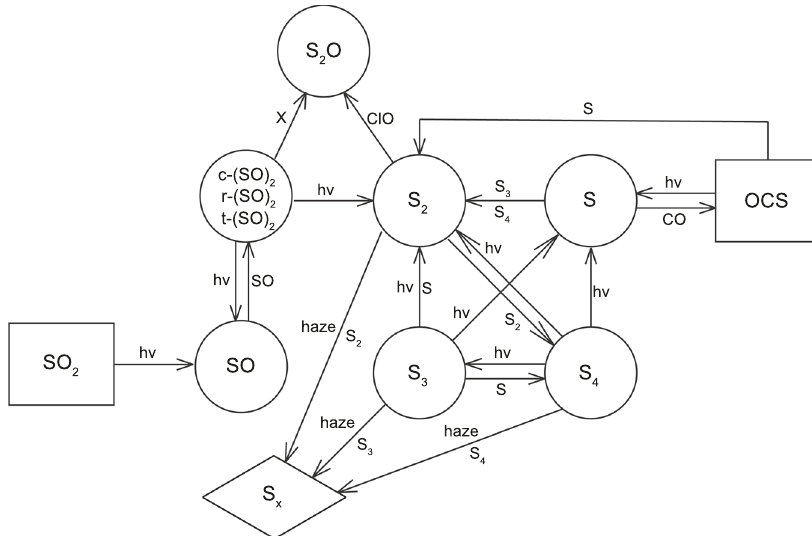
Fig. 4 Major reactions in the model. Schematic diagram showing the main routes for producing S x (shown in the diamond) from parent molecules, SO 2 and OCS (shown in rectangles) in the model. Intermediate species are shown in the circles. Species needed for the reactions are written next to the arrows. X can be O, H, NO, S, SO, S 2